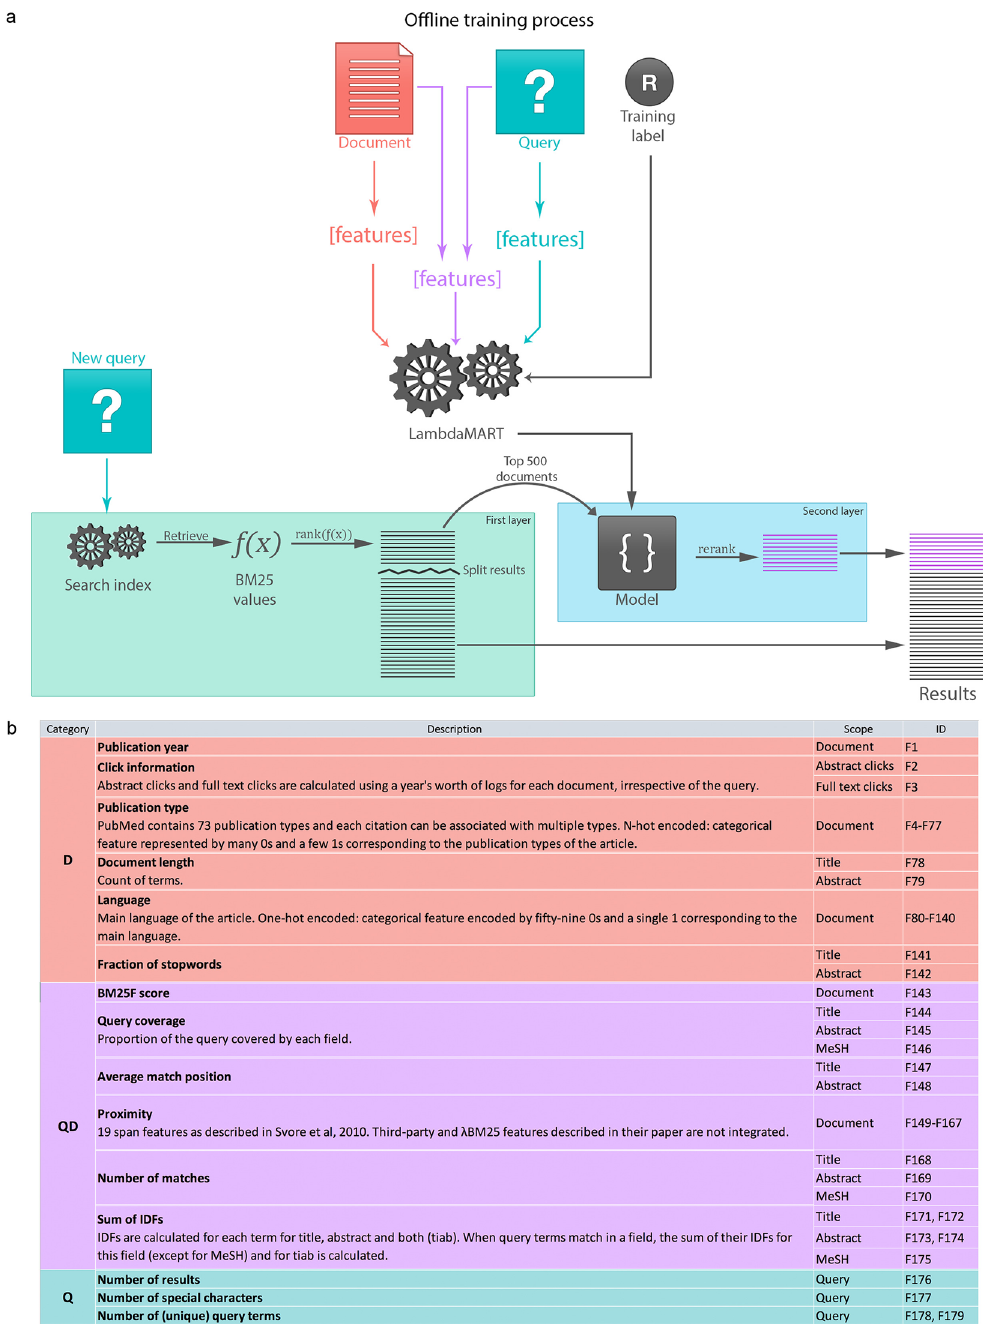
Fig 1. The overall architecture of the new relevance search algorithm in PubMed. (a) It consists of two stages: processing first by BM25, a classic term-weighting algorithm; the top 500 results are then re-ranked by LambdaMART, a high- performance L2R algorithm. The machine-learning–based ranking model is learned offline using relevance-ranked training data together with a set of features extracted from queries, documents, or both. (b) Features designed and experimented in this study with their brief descriptions and identifiers. D, document; IDF, inverse document frequency; L2R, learning to rank; Q, query; QD, query–document relationship; TIAB, title and